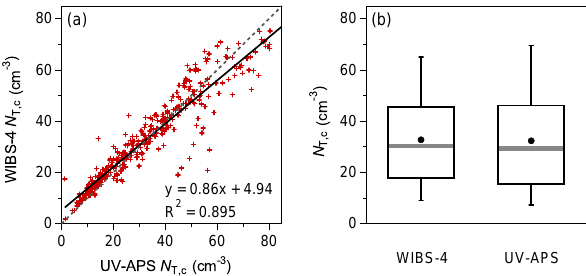
Figure 1. Comparison of concentrations of total coarse particles ( D >1µm) over the entire ∼ 1 month measurement period. Red symbols (a) show 5min data points, and the solid black line shows linear fit (not weighted). Dashed line is 1:1 line. Statistical sum- mary of N T , c shown as box-and-whisker plots (b) . Black dots show the mean, the horizontal gray bar shows the median, boxes show the 25–75th percentile, and vertical bars show the 5–9th percentile.